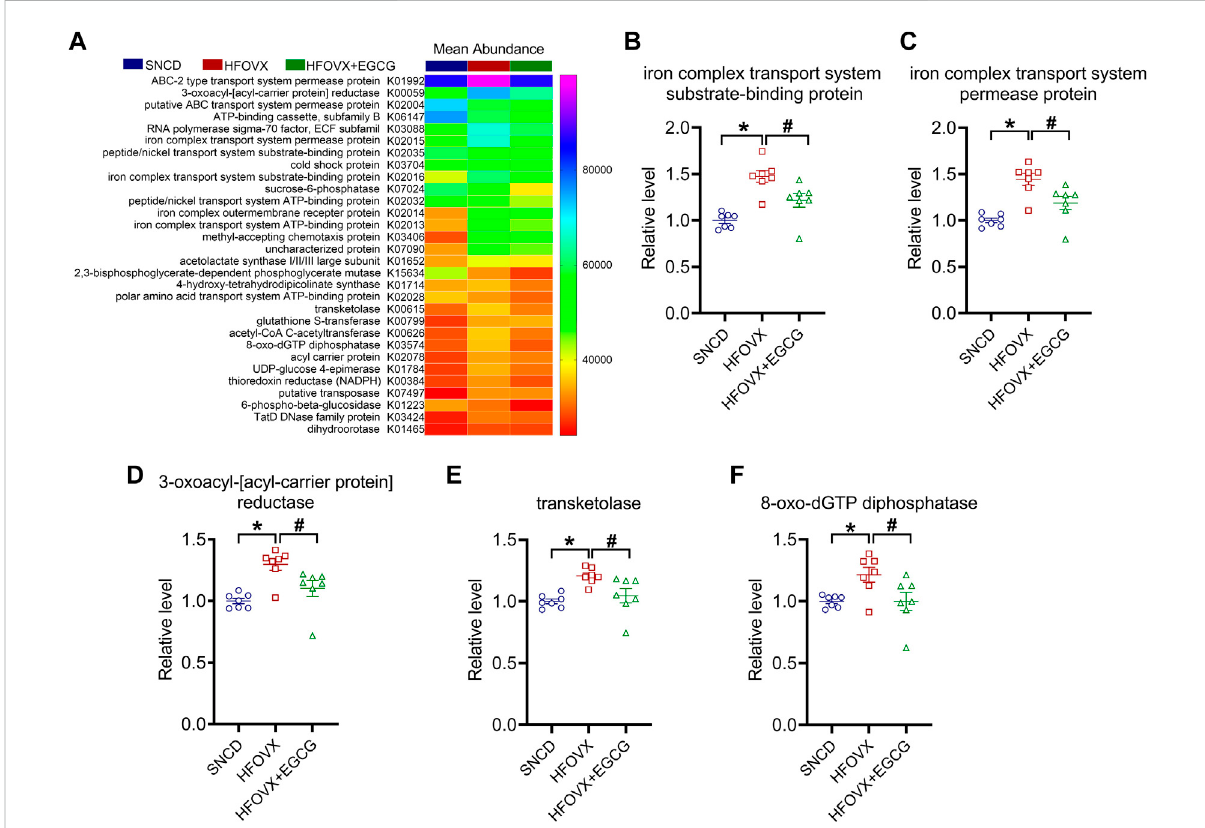
FIGURE 7 Functional gene predictions of the gut microbiota related to EGCG. (A) Heatmap shows the top 30 KOs closely associated with HFOVX and EGCG. (B – F) Relative abundance of the fi ve functional genes of gut microbiota was signi fi cantly different. * p < 0.05, HFOVX group vs. SNCD